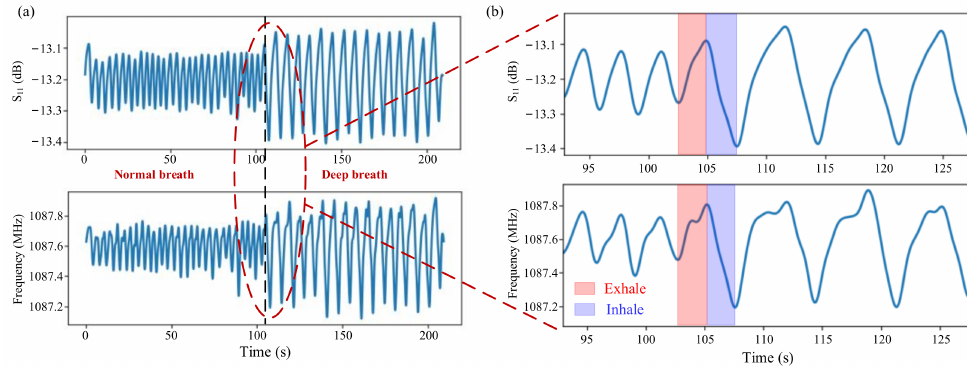
Figure 10. ( a ) S 11 and frequency responses with breathing time for normal breathing condition and deep breathing condition; ( b ) Partial enlargement of ( a